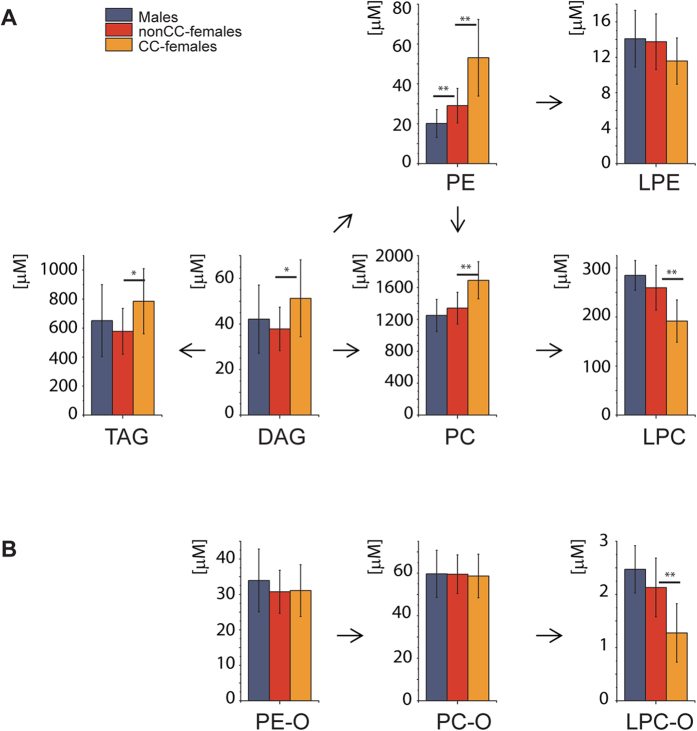
Contraceptives affect concentrations of GL and GPL, but not GSL.(A) Concentrations of some GL and GPL classes in males (n = 36), nonCC-females (n = 16) and CC-females (n = 19). (B) Concentrations of ether lipids and (C) GSL in the same cohort. Arrows indicate major pathways of lipids biosynthetic conversion. *p < 0.05; **p < 0.01; ***p < 0.001 (Mann-Whitney nonparametric test with Benjamini-Hochberg correction). Data are the mean ± SD.